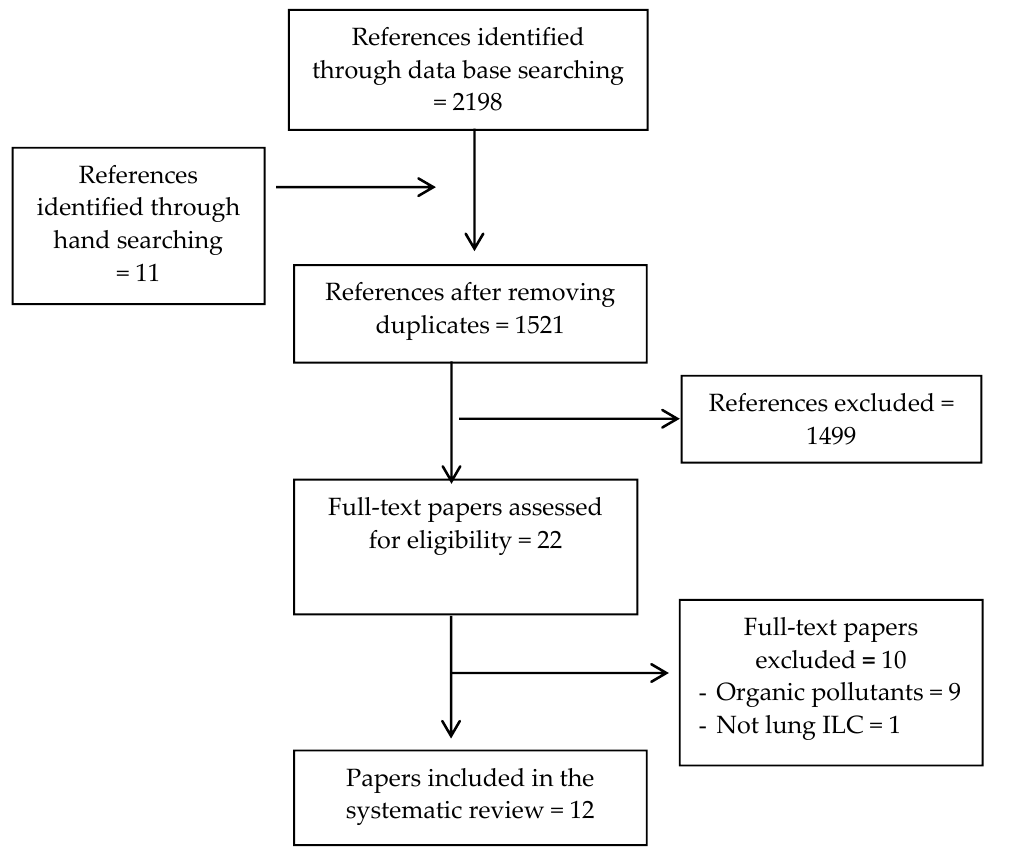
Figure 2. Flow diagram of study selection.